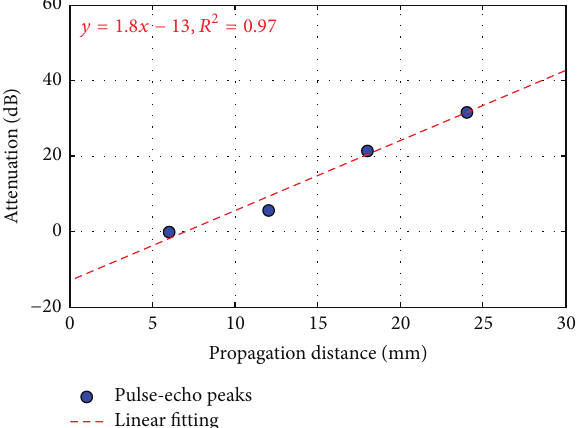
Figure 6: Attenuation depending on propagation